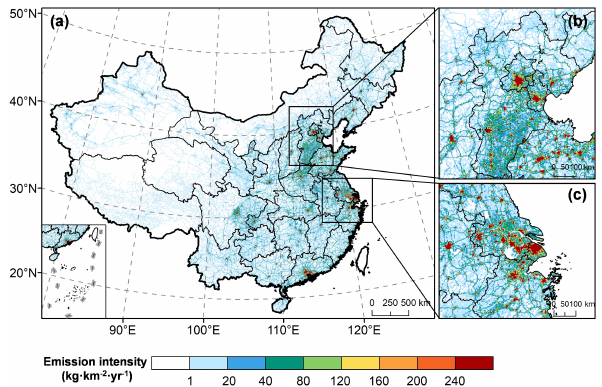
Figure 3. Spatial distribution of on-road NH 3 emission intensities in (a) mainland China, (b) the Beijing–Tianjin–Hebei (BTH) region and (c) the Yangtze River Delta (YRD) in